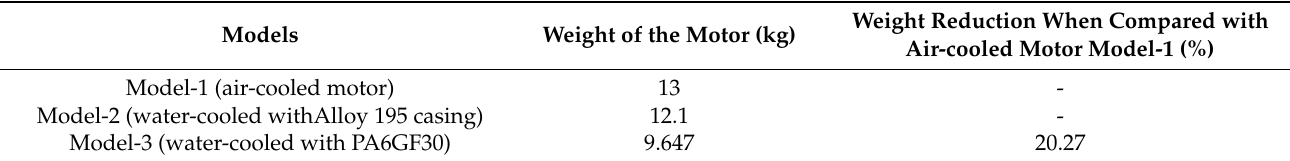
Table 19. Weight reduction for Case-2 and Case-3 when compared to air-cooled motor